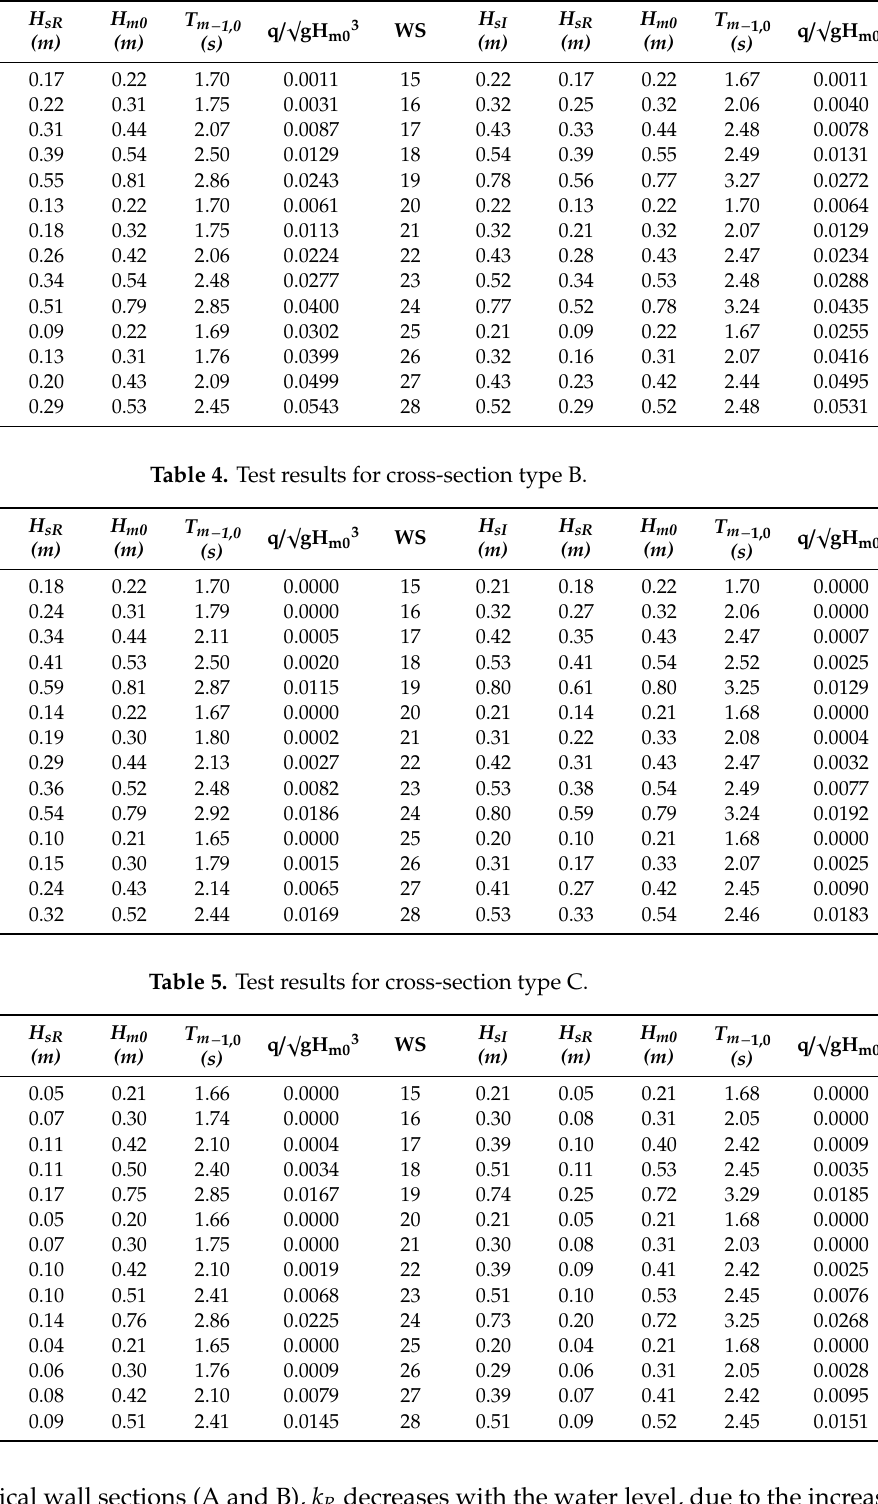
Table 3. Test results for cross-section type A.